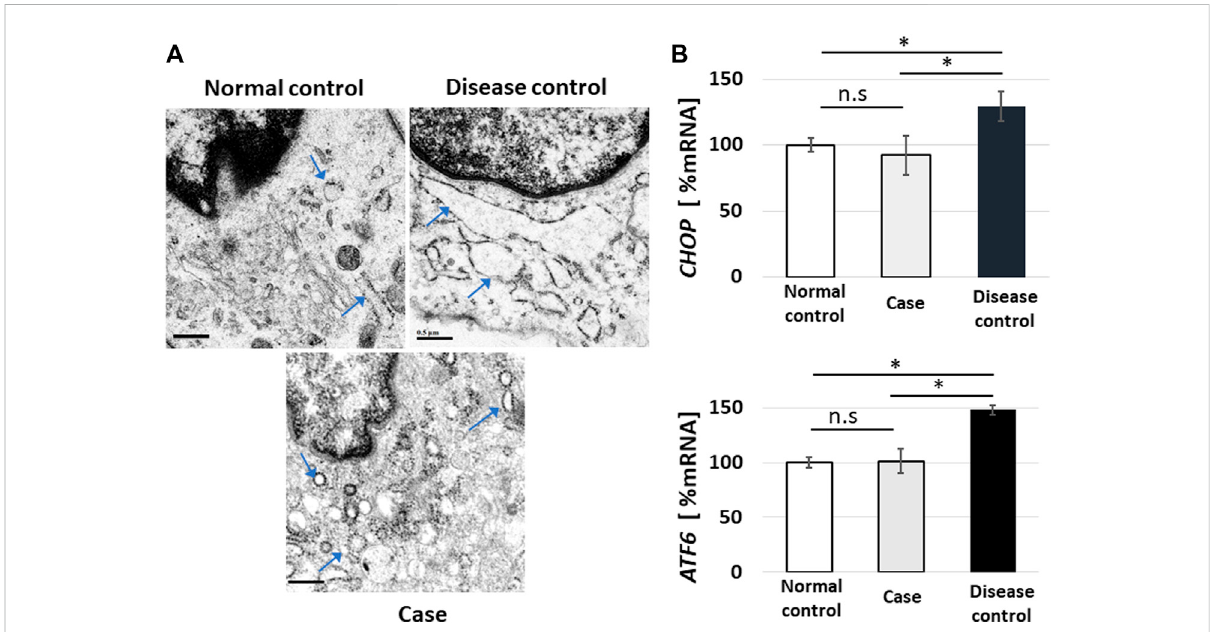
FIGURE 4 Endoplasmic reticulum (ER) stress and real-time reverse-transcription polymerase chain reaction (RT-PCR) for unfolded protein response sensors.FibroblastsshowednodilationoftheERinthenormalcontrol,butimagesshowingdilated fi broblastsoftheERwereobtainedinthedisease control. In the present case, the expansion of the ER was not noticeable (arrowheads indicate ER (A) ; bar, 0.5 µm). In real-time RT-PCR using mRNA extractedfromcultured fi broblasts,PCRwasperformedonfourtechnicalreplicatesofeachmRNAsample,andtheresultswereaveraged. ATF6 and CHOP were highly expressed in the disease control when compared to the normal control; however, their expression levels in the present case were almost the same as those of the normal control (B) , error bar: standard error, ns: not signi fi cant, * p <